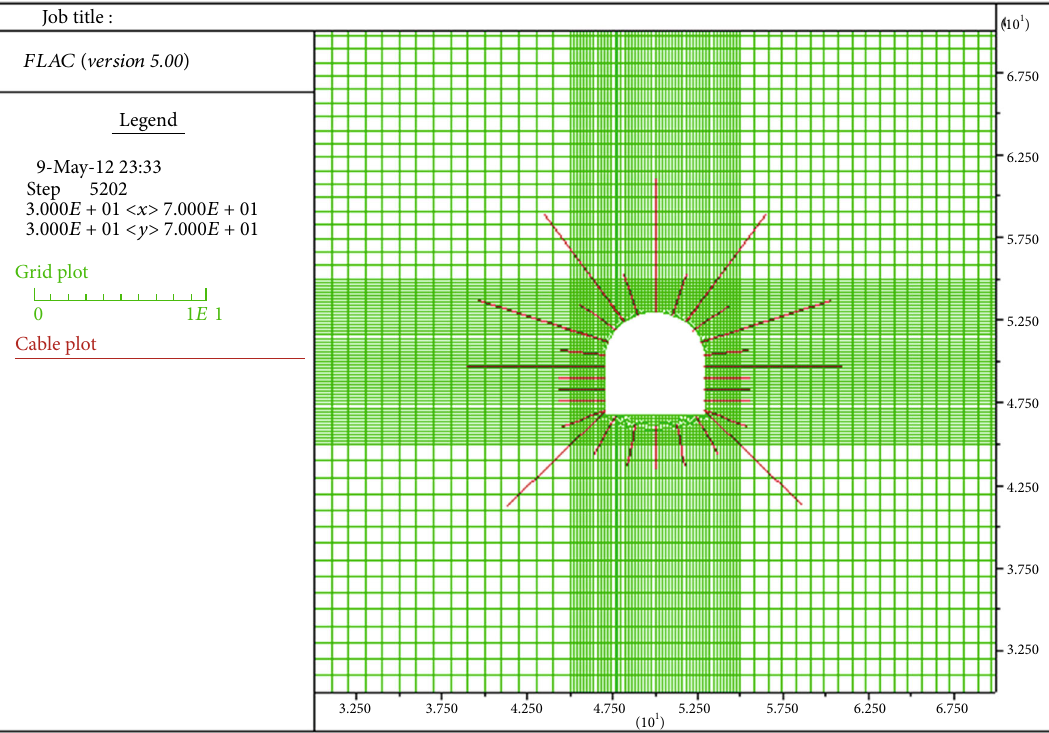
Figure 11: Calculation model of the MPC restoration support